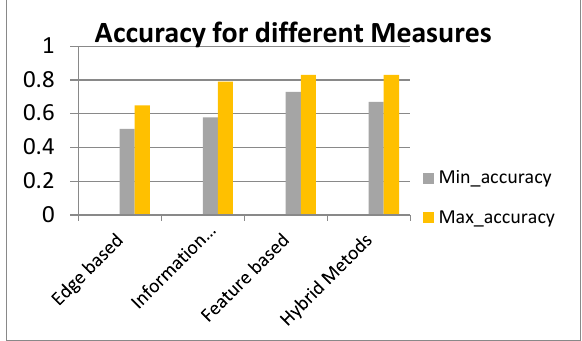
Figure 5 Accuracy Graph for the different measures